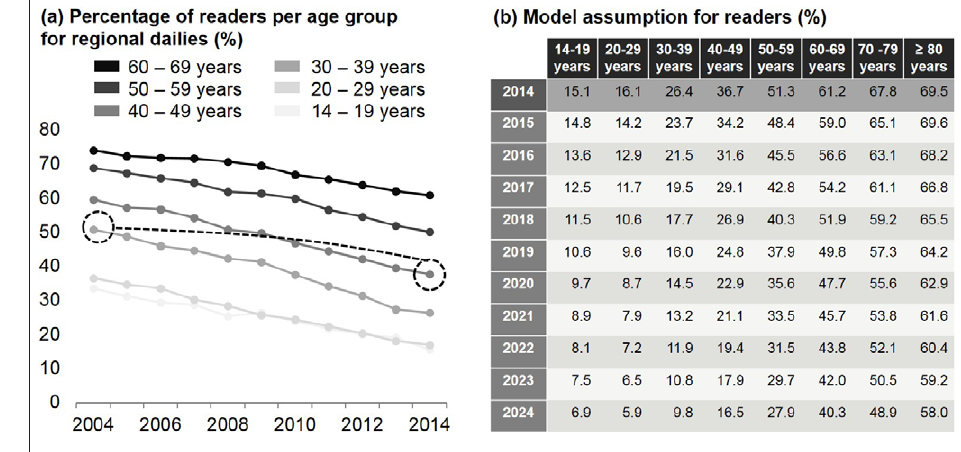
Figure 7: Analysis of past print-online substitution and model development for regional dailies. Source : Own elaboration based on historic data from AWA (2014).